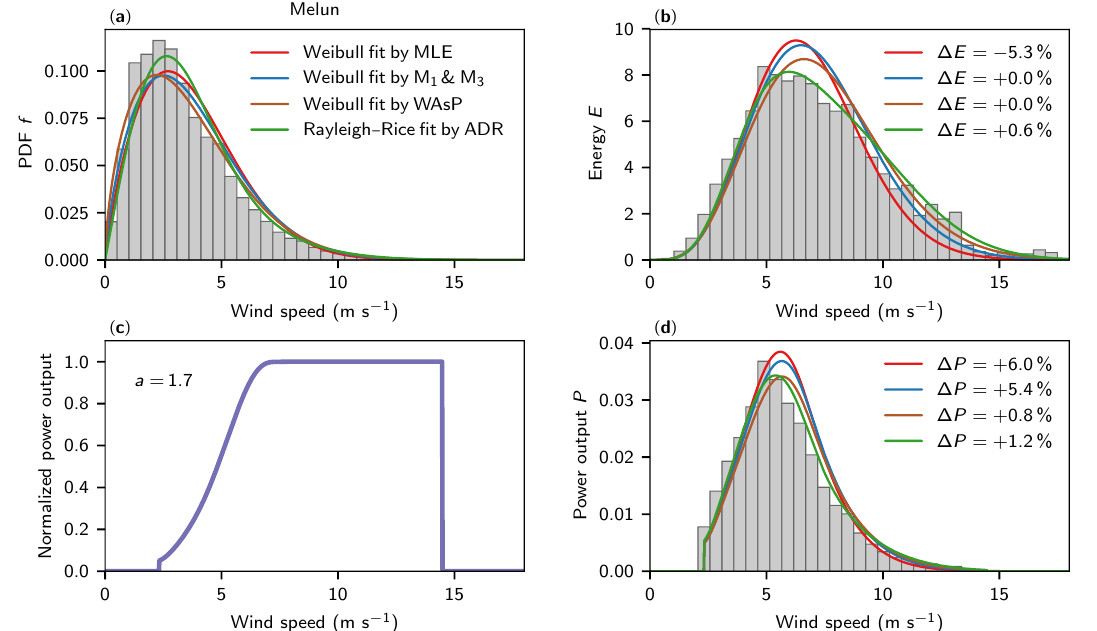
Figure 4. Representation of the energy and production calculations at Melun station (2010–2013). (a) Histogram of the observed wind-speed series and probability density function f (w) of the fitted distributions (Weibull fit by MLE, moments, or WAsP methods and Rayleigh–Rice fit). (b) Wind energy content as a function of wind speed w (i.e., f (w)w 3 ) for each distribution and associated histogram for the observations. (c) Power curve P a adapted to the station in order to have a capacity factor of 30%. (d) Wind power output as a function of wind speed (i.e., f (w) P a (w) ) for each distribution and associated histogram for the